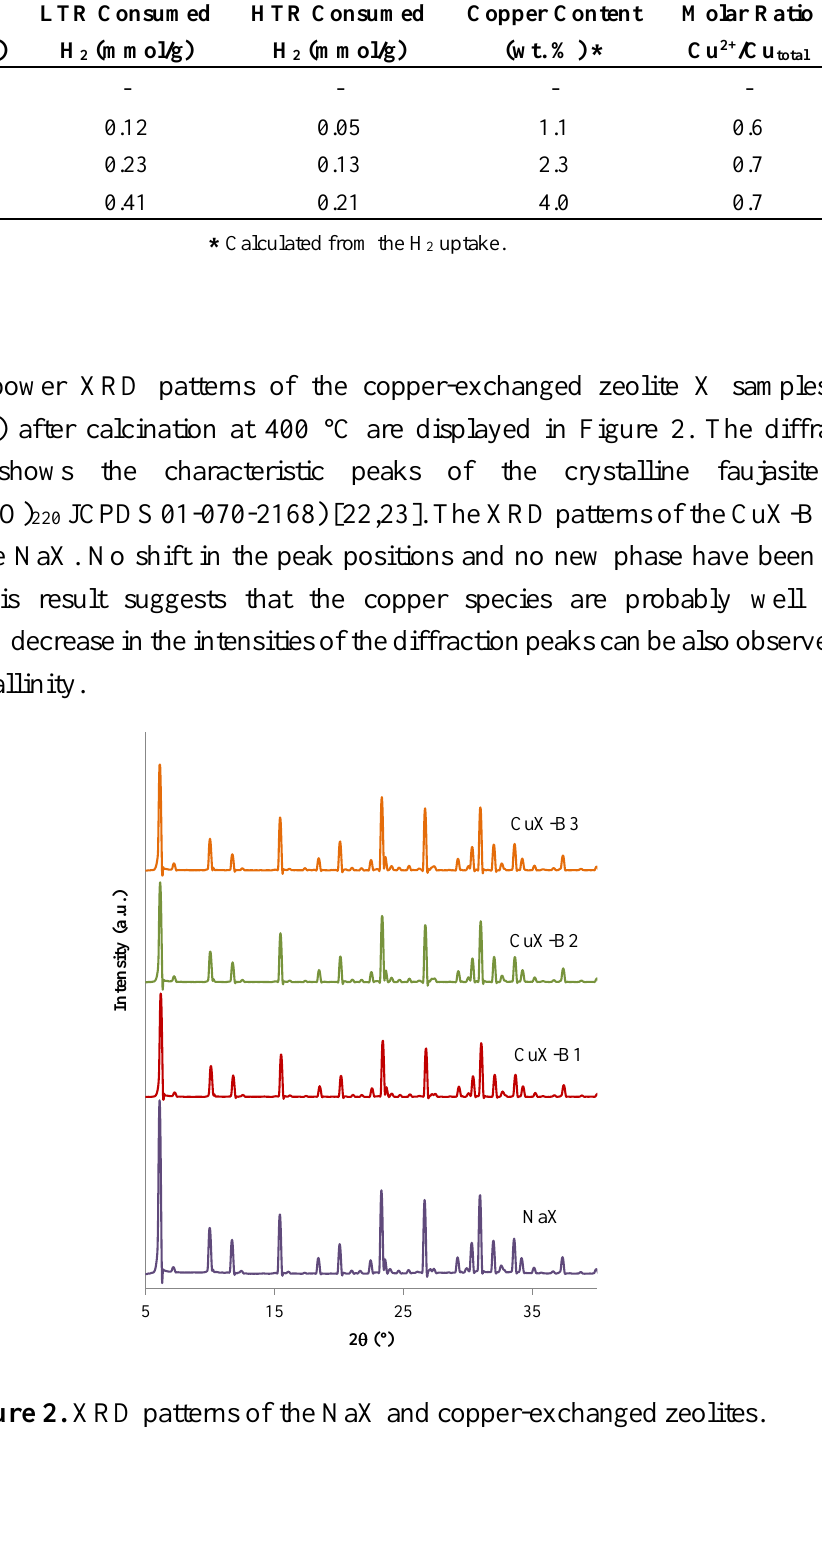
Table 1. Quantitative results from H 2 -TPR experiments for NaX and copper-exchanged zeolites. Sample